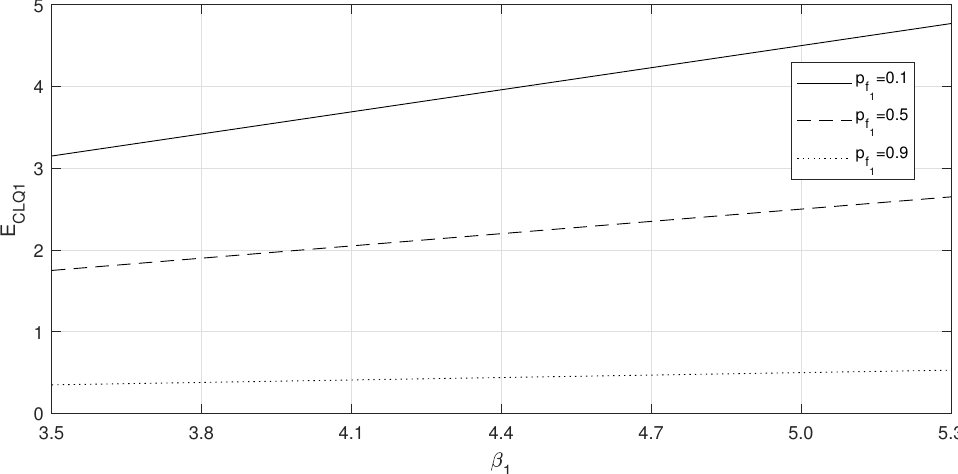
Figure 3. Expected customers lost in Queue-1 on p f